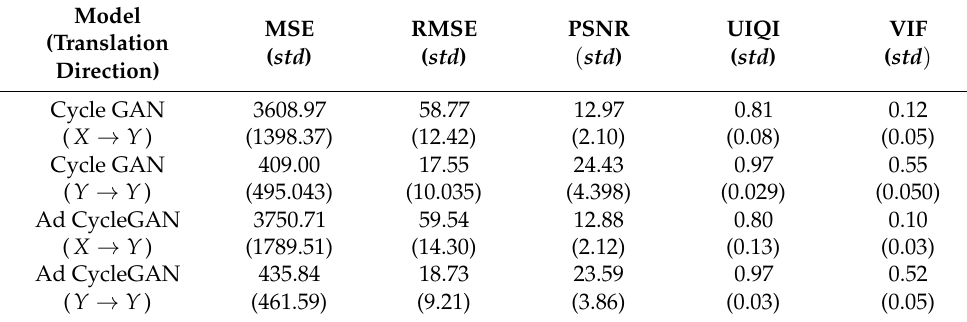
Table 1. Quantitative metrics for the synthetic Images.